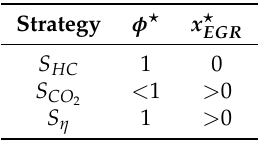
Table 11. Simplified optimal